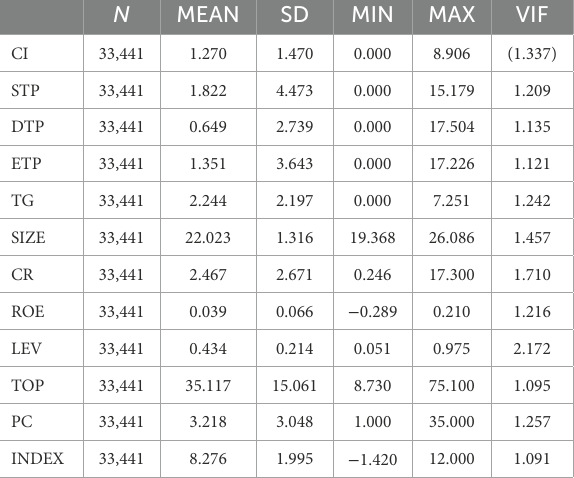
TABLE 3 Descriptive statistics of main variables and the value of